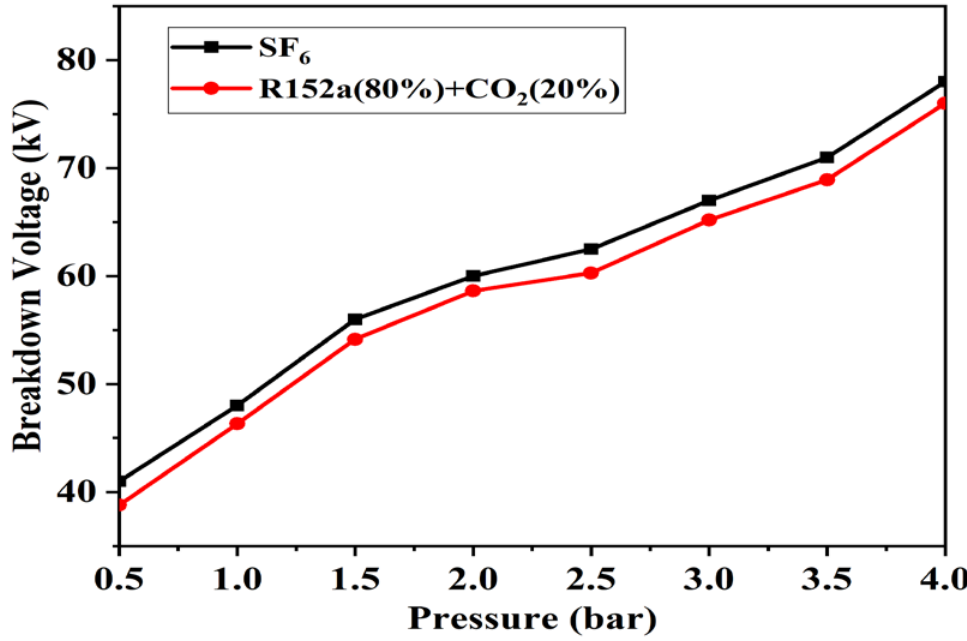
Figure 4. Breakdown characteristic comparison of R152a/CO 2 gas at 80%/20% mixture ratio and SF 6 at 8 mm electrode gap distance.